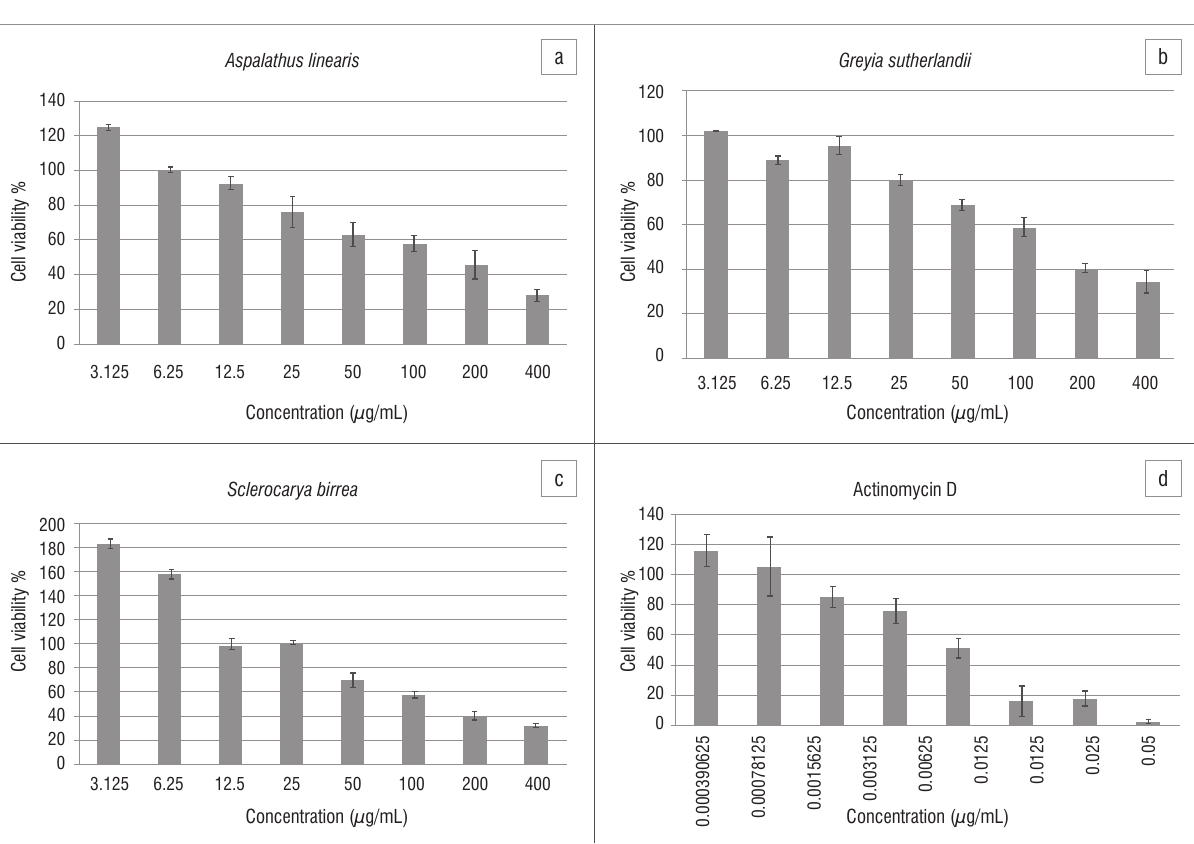
=107.85±1.53 µg/mL), (c) Sclerocarya birrea (EC 50